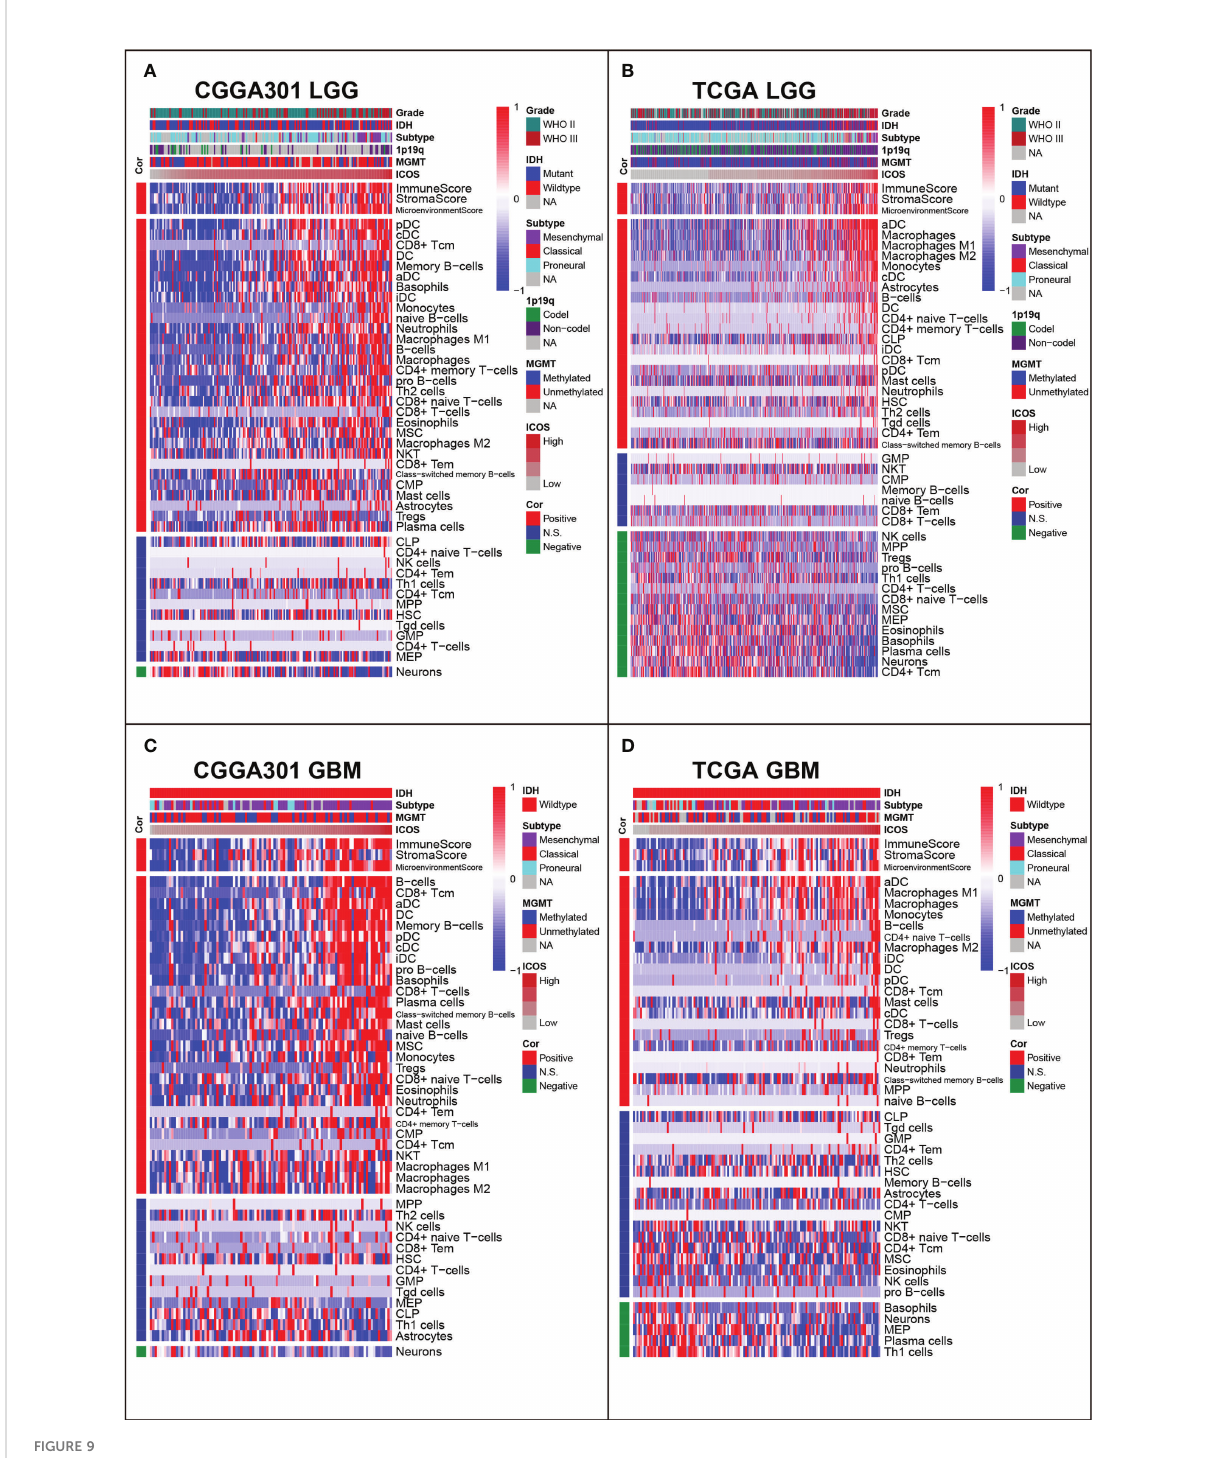
FIGURE 9 Relationship between ICOS and immune cell subpopulations in CGGA301 and TCGA datasets. (A) Correlation between ICOS and immune cell subpopulations in CGGA301 lower-grade glioma. (B) Correlation between ICOS and immune cell subpopulations in TCGA lower-grade glioma. (C) Correlation between ICOS and immune cell subpopulations in CGGA301 glioblastoma. (D) Correlation between ICOS and immune cell subpopulations in TCGA